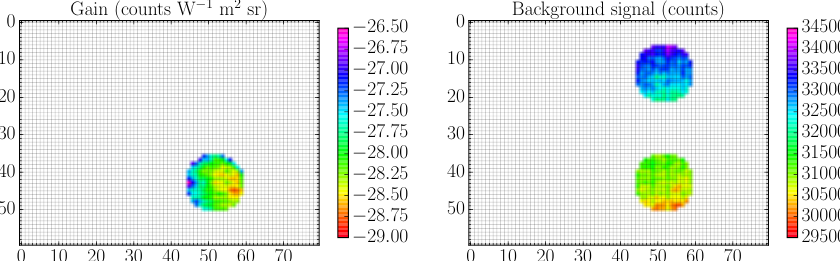
Figure 3. 2-D maps of gain and background signal for filter 7.9–9.5µm for measurements acquired in the laboratory with T HBB = 55 ◦ C and T ABB = 24 . 5 ◦ C. Only the 193 pixels used for data analysis are colored. On the right panel, the upper circle shows the non-illuminated area used for the calibration